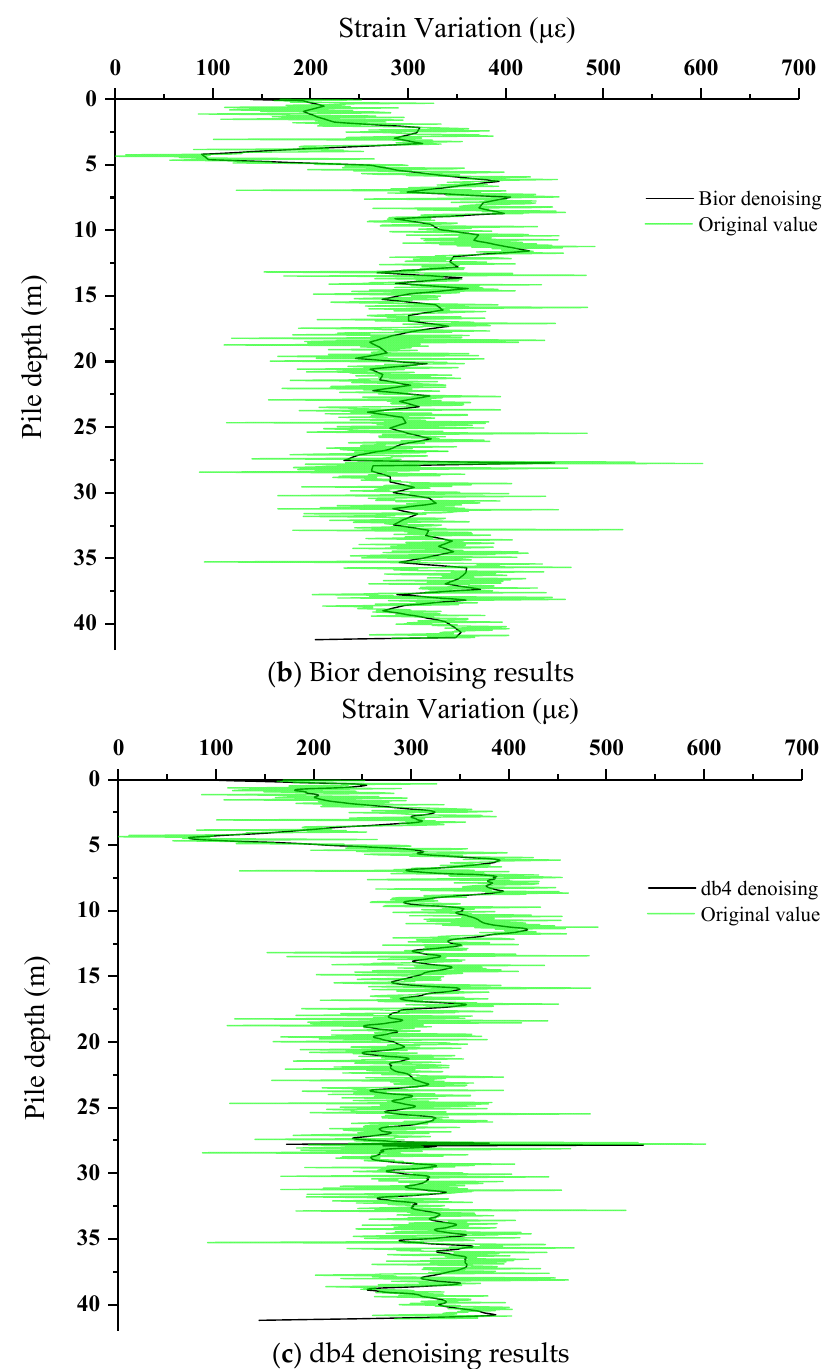
Figure 6. Result of the data processed of optical fiber sensor.